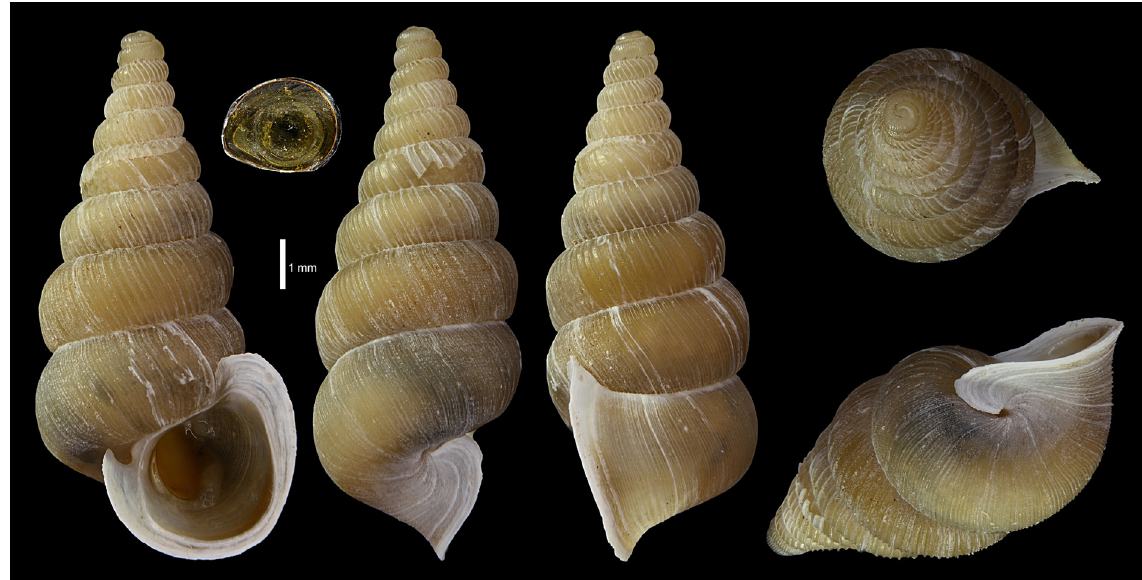
Fig. 8. Cochlostoma (Lovcenia) erika (A.J. Wagner, 1906), Popova Cave near Njeguš, Pljevlja, Montenegro (HNHM